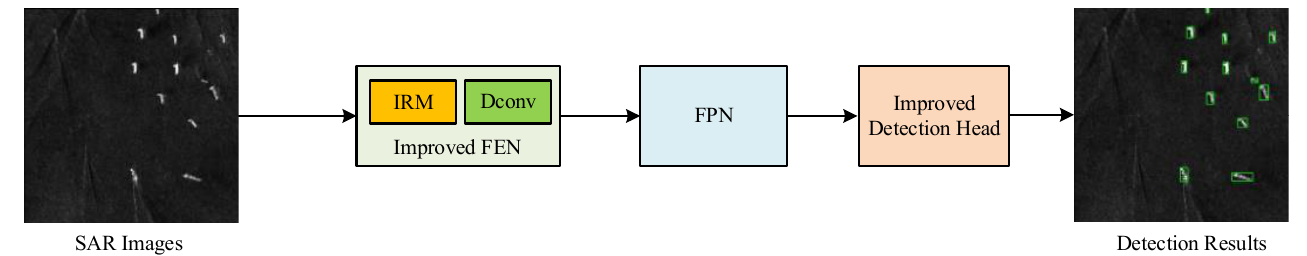
Figure 3. The overall flowchart of the proposed method.